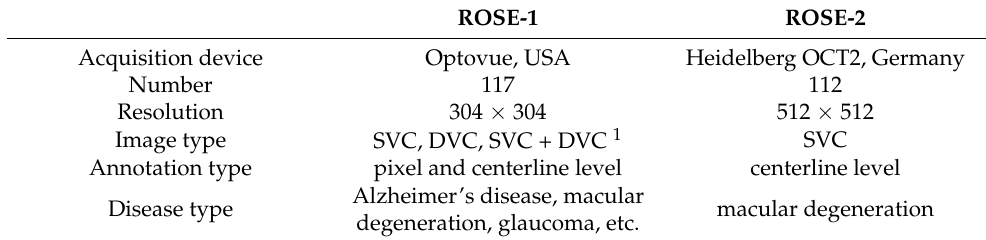
Table 1. Details of the ROSE dataset.